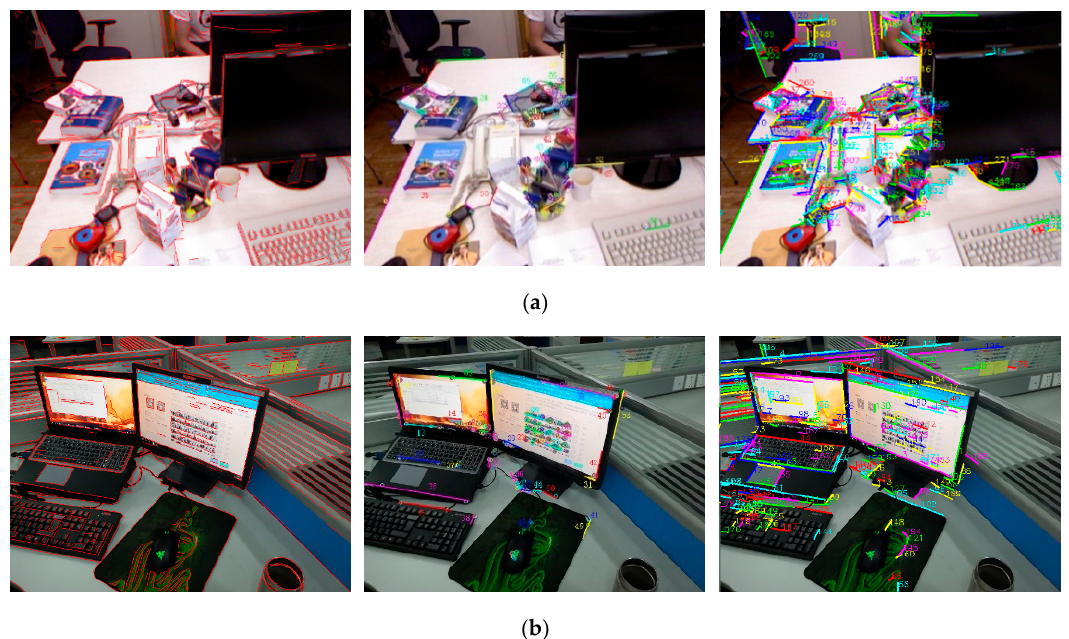
Figure 8. Examples of matches: ( a ) TUM fr1_xyz; ( b ) hand-held camera. Line segments are detected by LSD ( left) and matched by our algorithm ( middle) and LBD ( right ) in an example pair of pictures from TUM fr1_xyz. The matched line segments are numbered and drawn on one picture of the pair. In the middle picture of our algorithm, the ORB feature points are marked by colorful circles.